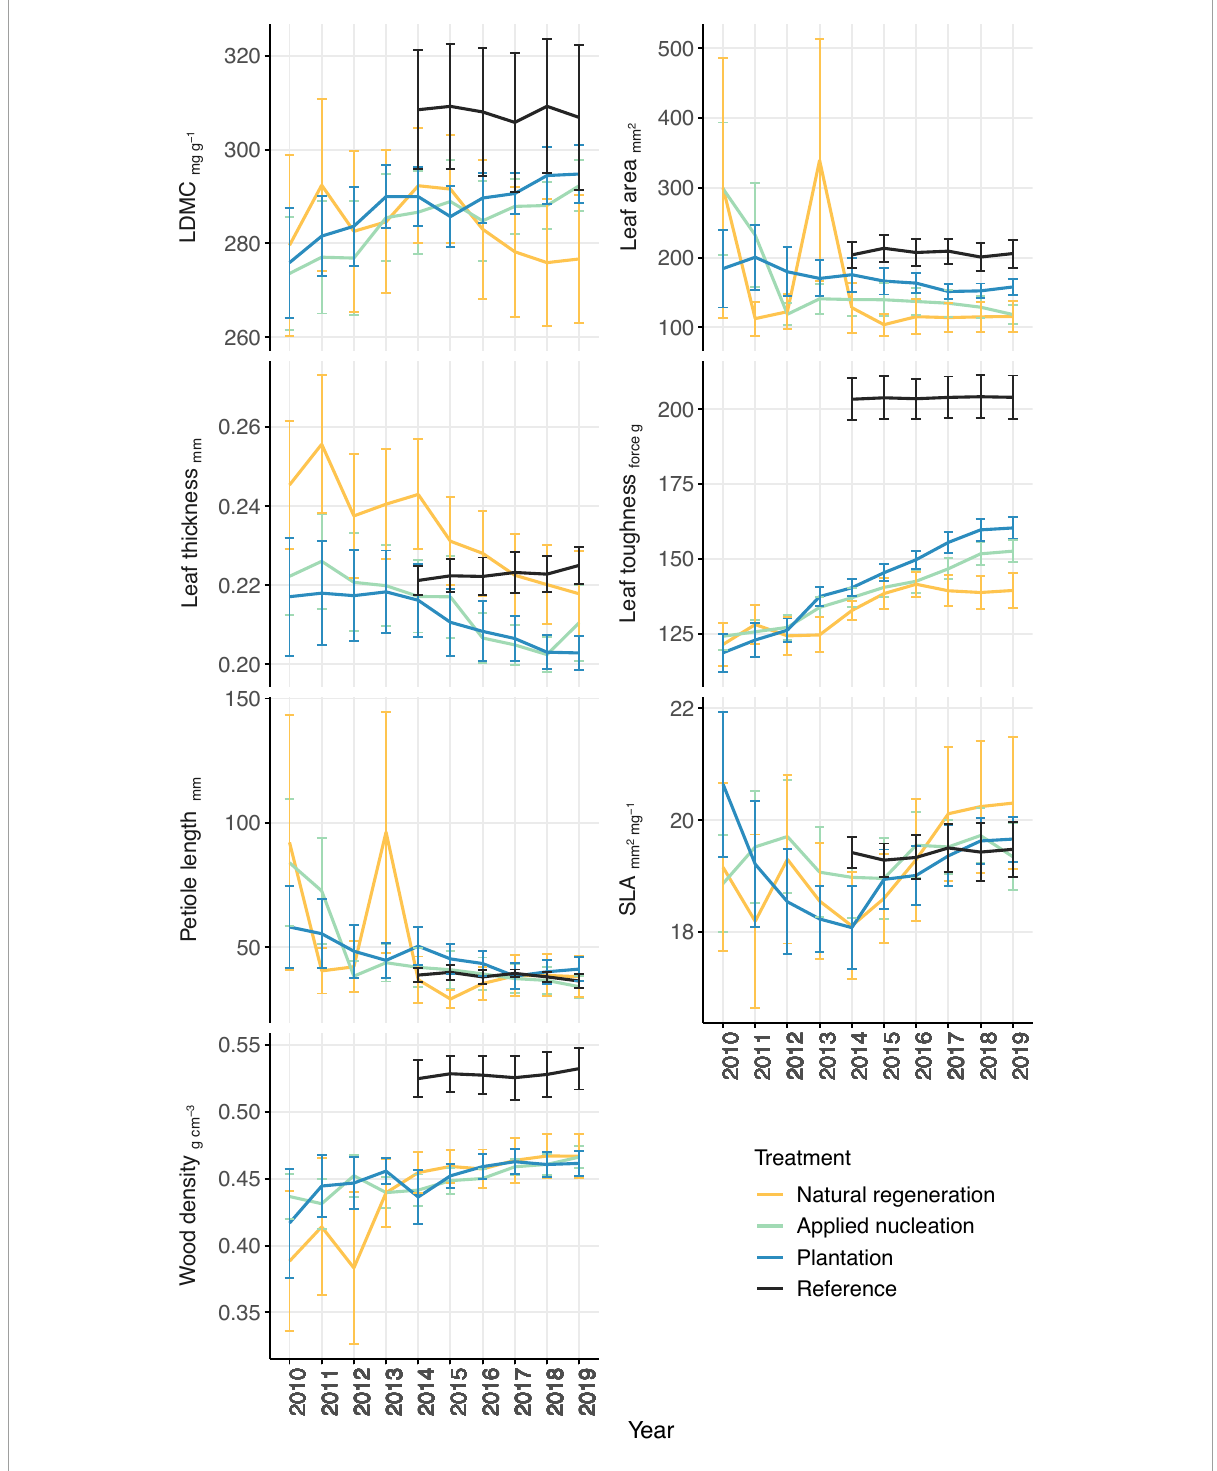
FIGURE1 Annual treatment-level means ( ± SE) of tree sapling functional trait community-weighted means (CWMs) from 2010 to 2019 (2014–2019 in reference forest) in each of the treatments. Sample size: n = 11 sites in applied nucleation, natural regeneration, and plantation; n = 5 sites in reference; for wood density, n = 10 sites in natural regeneration as one outlier was